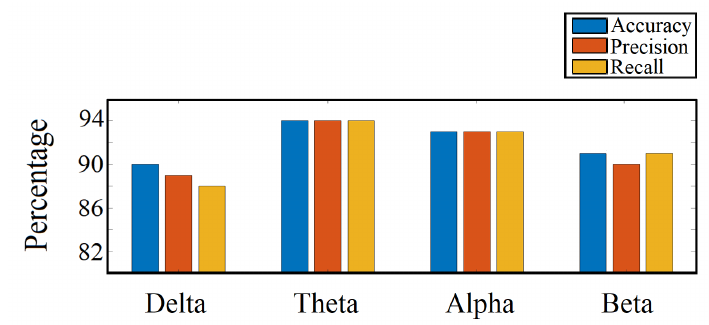
Figure 14. Frequency band performance